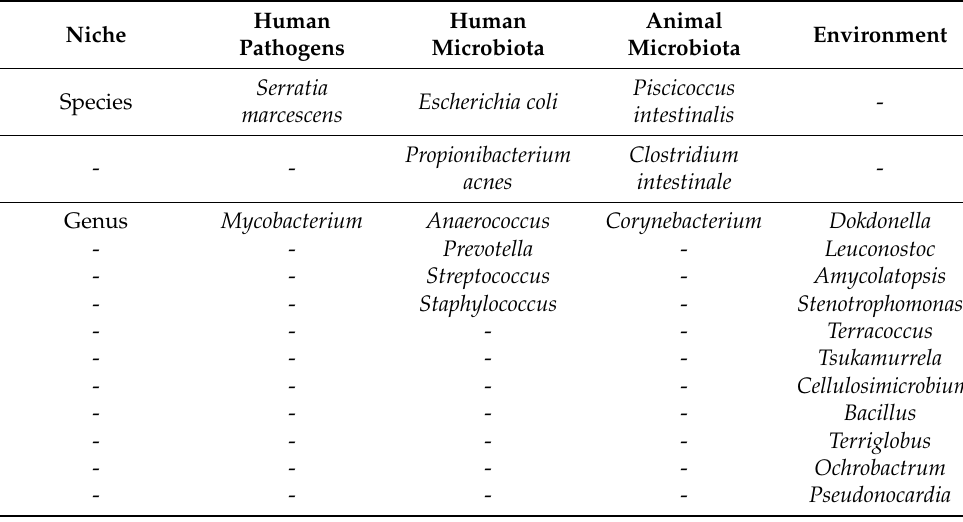
Table 2. Genus and species identified by next-generation